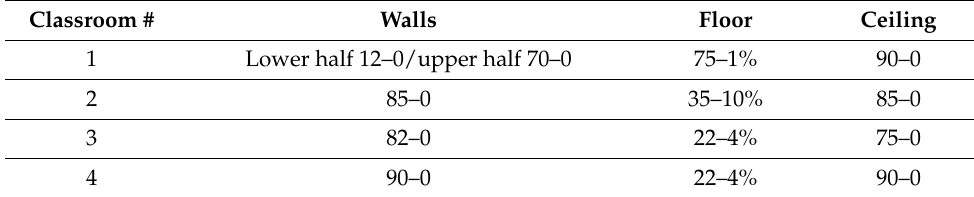
Table 2. Classroom characteristics: reflection factor and reflective coating.